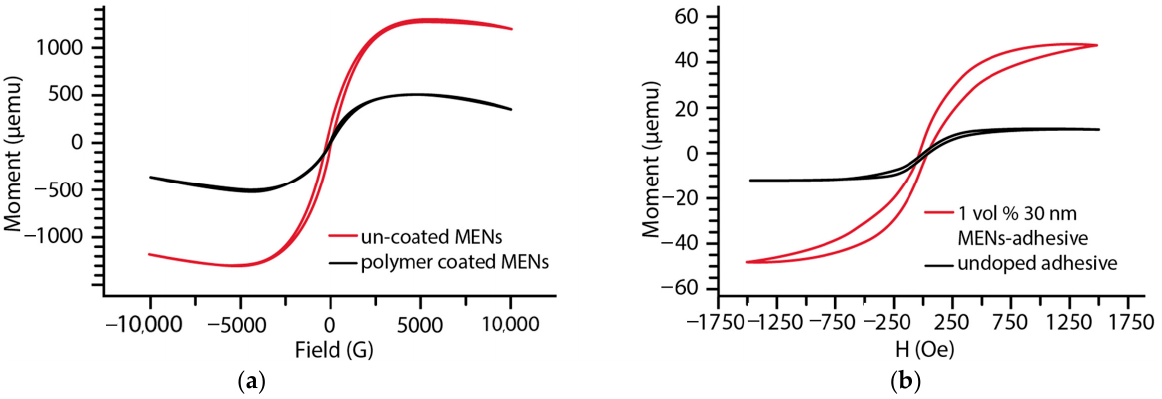
Figure 3. ( a ) Magnetic response of free MENs vs. polymer-coated MENs; ( b ) influence of MEN doping on the magnetic signal on a polymer adhesive.